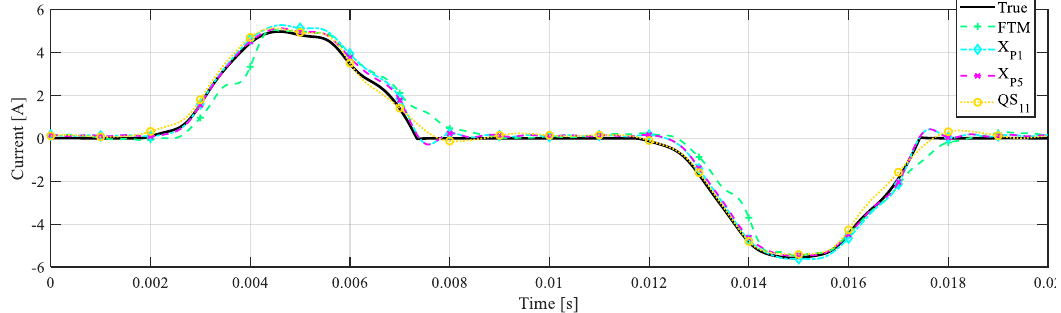
Figure 4. Time-domain reconstruction of i G for the different models.